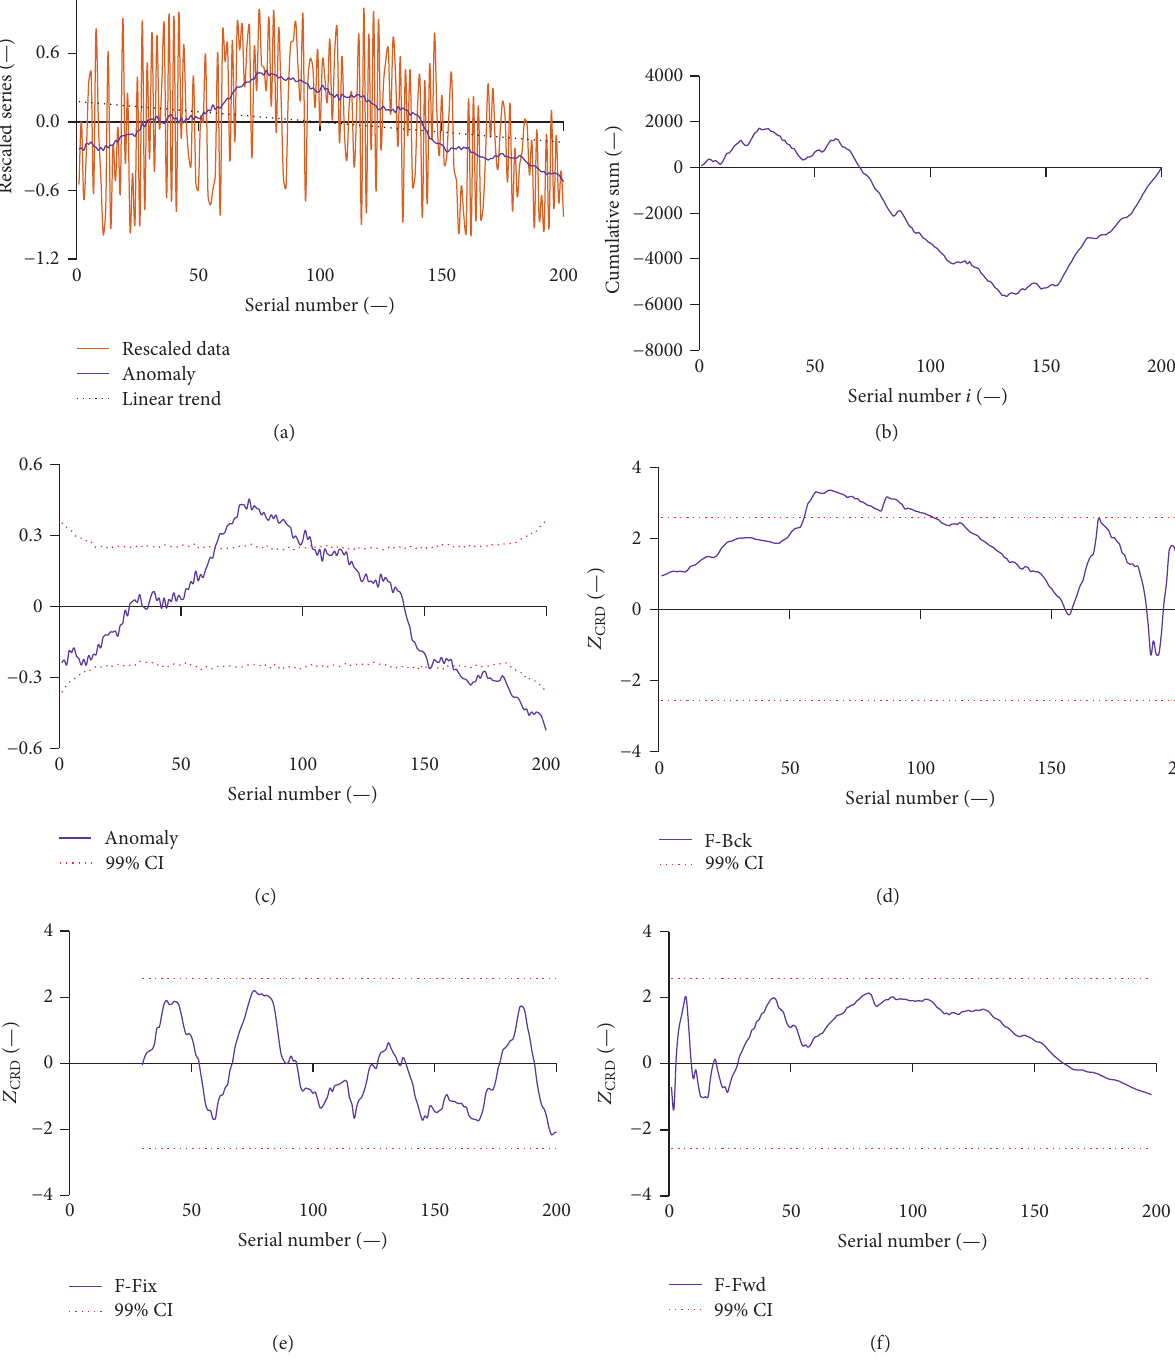
in a combined way by fixing the initial window for the subseries around the centre of the